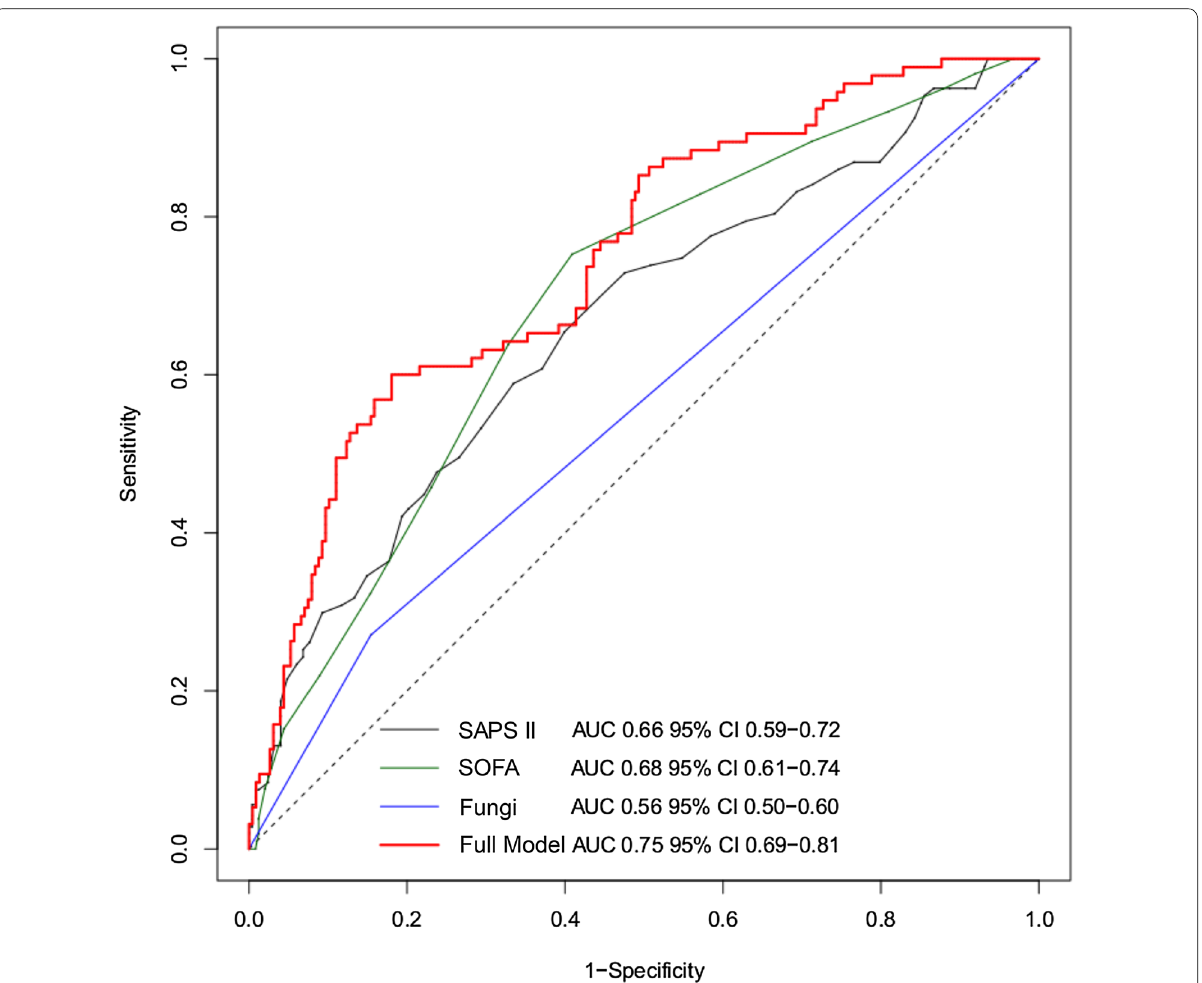
Fig. 3 ROC curves comparing the predictive accuracy of the multivariable regression model (red curve) for all patients with each parameter used in the model: SAPS II (gray curve), SOFA D1 (green curve) and fungal infection (blue curve). SAPS II, Simplified Acute Physiology Score; SOFA, sequential organ failure assessment calculated the first day of administration of